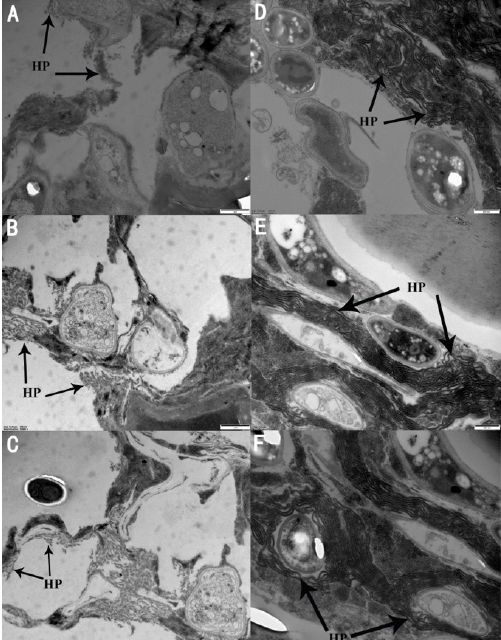
Figure 5. Scanning electron microscope images of the cross sections of M. usitatus bodies showing the growth of A. attenuatus in M. usitatus . ( A – C ) Five days post-infection with SCAUDCL-38; ( D – F ) five days post-infection infection with SCAUDCL-56. HP: hyphae.